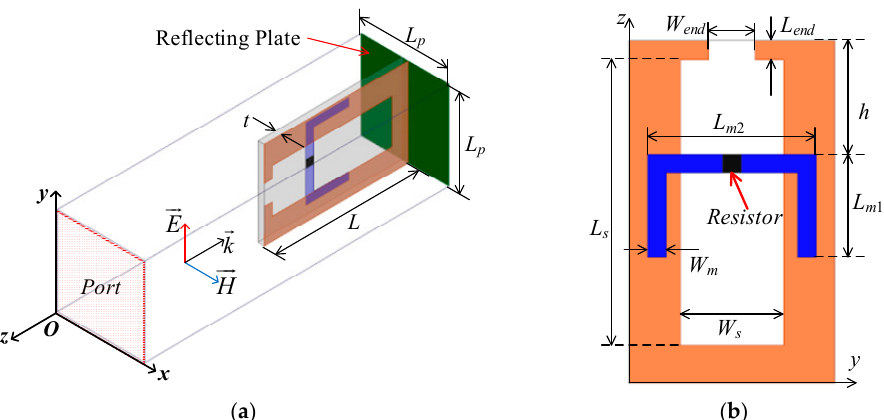
Figure 1. ( a ) Perspective and ( b ) 2D view of the proposed single-polarized 3D absorber. The parameters in Figure 1 are as follows: L p = 11.0 mm, t = 0.8 mm, L = 18.0 mm, L s = 15.0 mm, W s = 5.5 mm, L end = 1.0 mm, W end = 2.5 mm, W m = 1.0 mm, L m 1 = 5.4 mm, L m 2 = 9.0 mm, h = 6.0 mm and R = 200 Ω